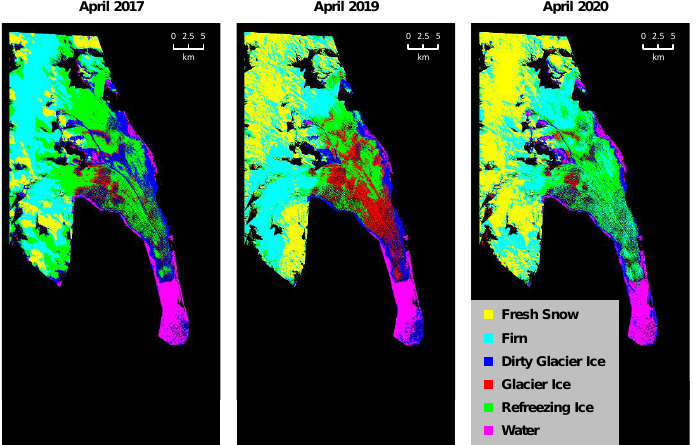
Figure 9. Classification results achieved for the scenes in April for the years 2017, 2019 and 2020, geographical mask and shadow mask applied. Note that all possible shadow extents are excluded by one mask applied to all investigated scenes.